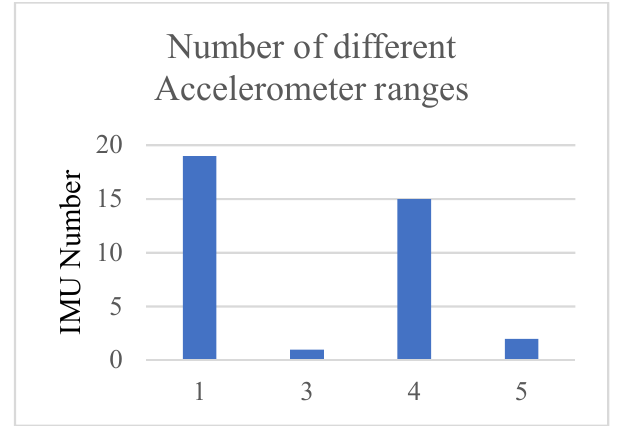
Figure 5. The different ranges of Accelerometers.